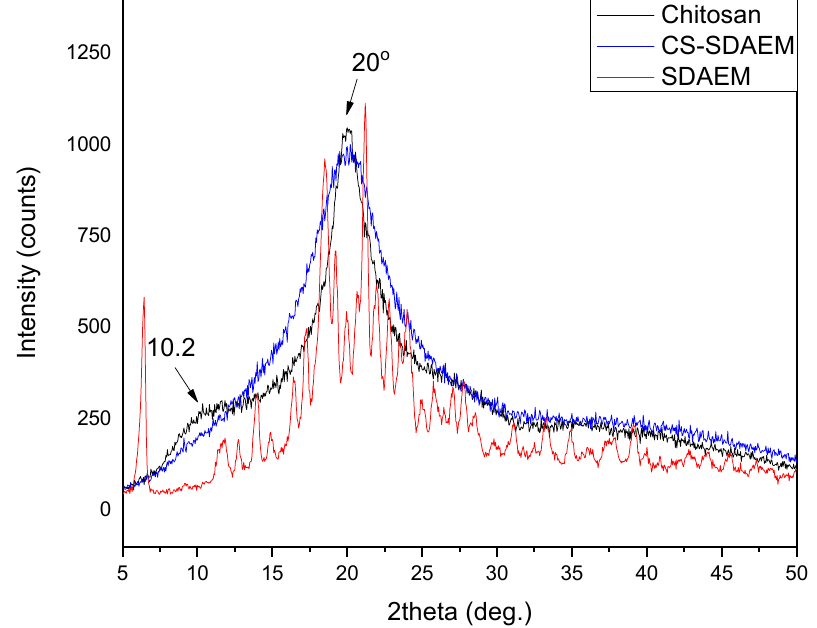
Figure 4. XRD patterns of neat CS and CS-SDAEM derivative.